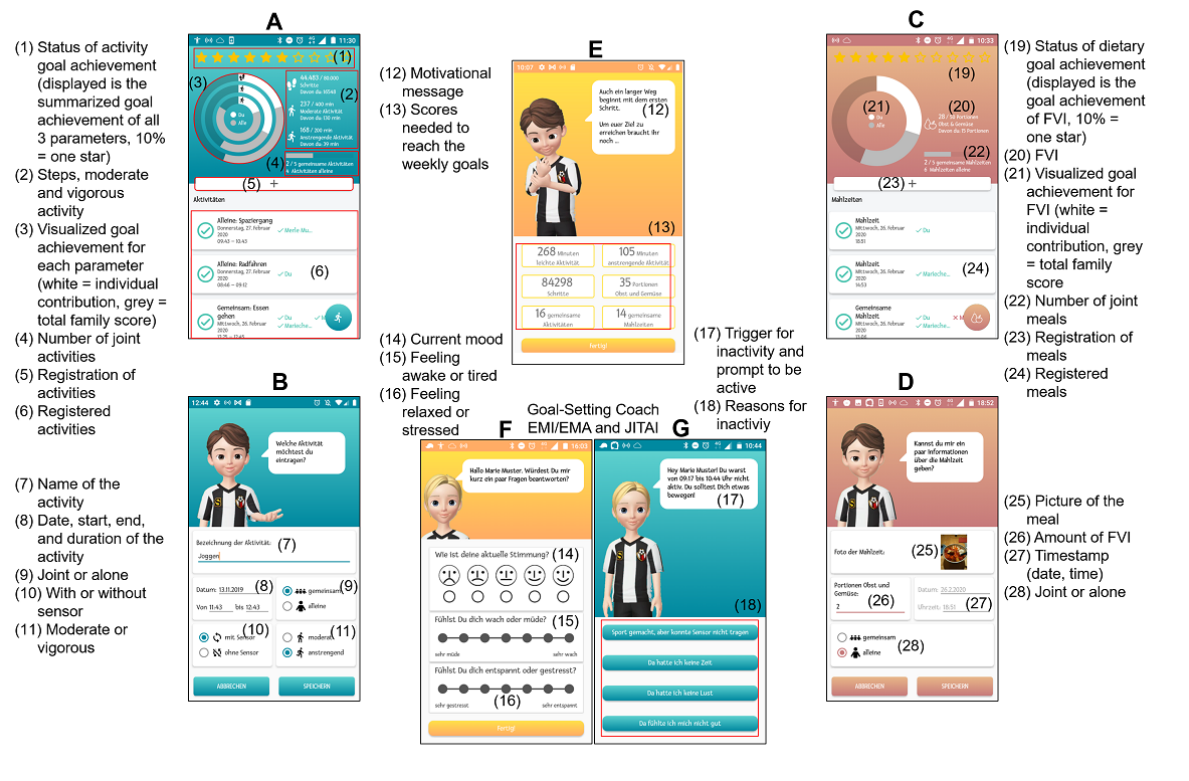
Figure 5. Examples of SMARTFAMILY2.0 app screens. A. Detailed status of activity goal achievement; B. Manual activity recording; C. Nutritional goal achievement; D. Manual food recording; E. Morning screen with an overview of the status quo and remaining physical activity and fruit and vegetable intake until goal achievement; F. Ecological momentary assessment and ecological momentary intervention; G. Just-in-time adaptive intervention. EMA: ecological momentary assessment; EMI: ecological momentary intervention; JITAI: just-in-time adaptive intervention; FVI: fruit and vegetable